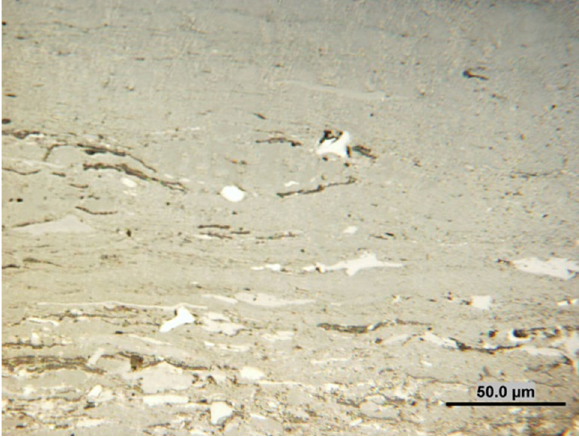
Fig. 4 Collotelinite with the belt of finely grained micrinite and dark cellular